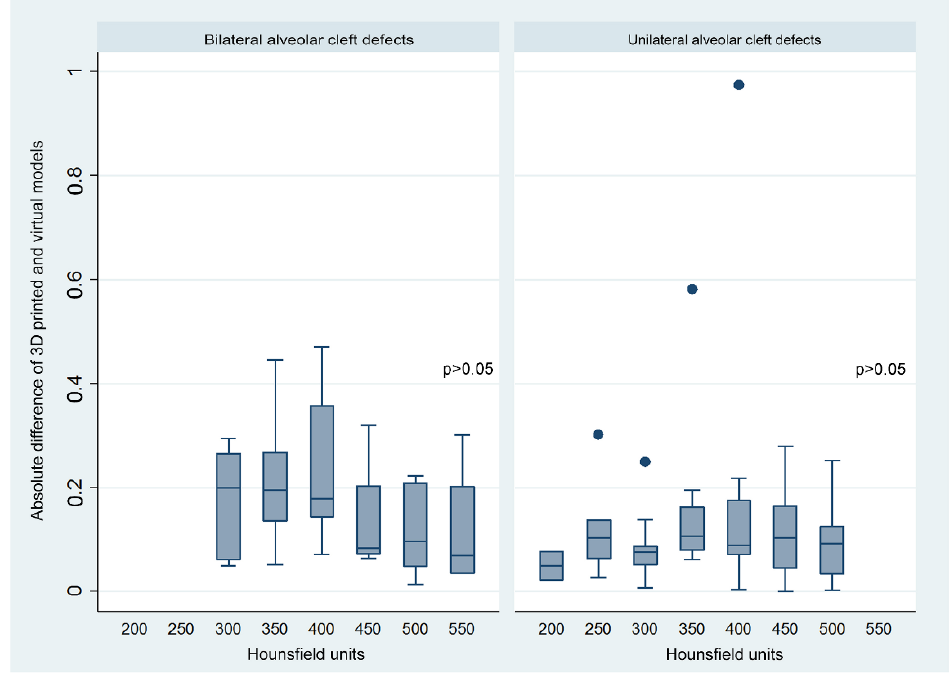
Figure 4. The absolute difference between 3D-printed and virtual-based surgical simulation methods showed no linear relationship with different Hounsfield units adopted for bilateral and unilateral alveolar cleft defects.